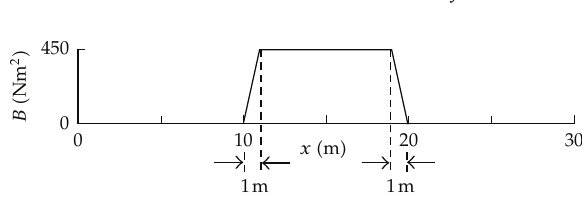
Figure 4: Distribution of flexural rigidity B given on the surface in the numerical